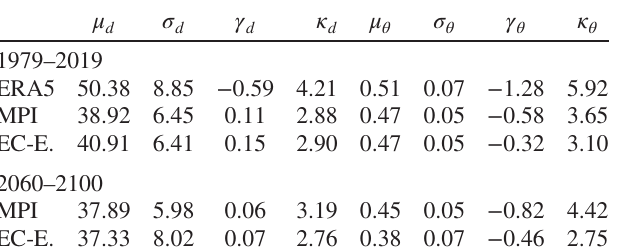
TABLE II. First four moments of the distributions of local dimensions and persistence. μ , σ , γ , κ are the mean, standard deviation, skewness, and kurtosis of the PDFs, respectively. The subscript d or θ indicates the different PDFs. Note that skewness and kurtosis for a normal distribution equal 0 and 3, respectively.